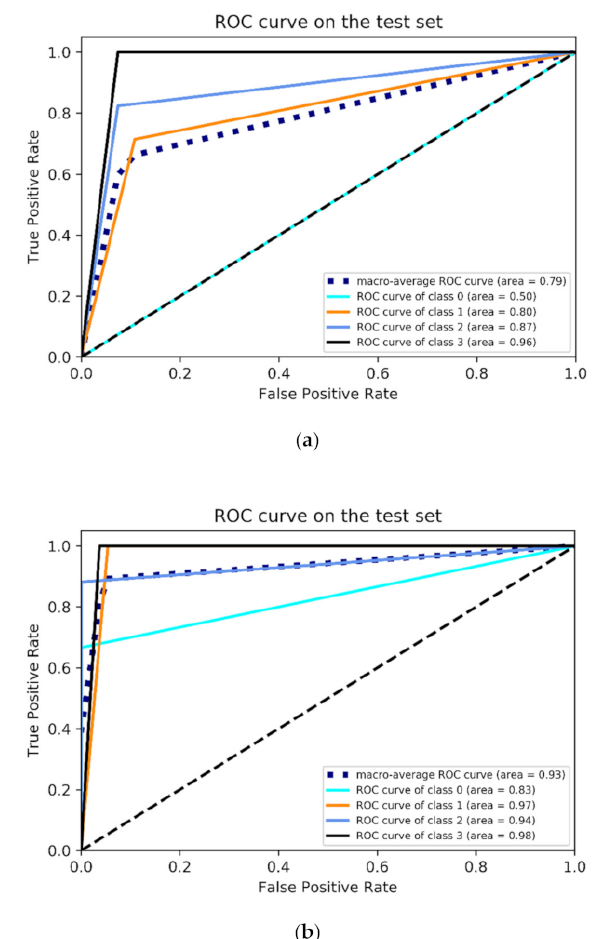
Figure 8. ROC curve of model on the test set. ( a ) Before data enhancement; ( b ) After data